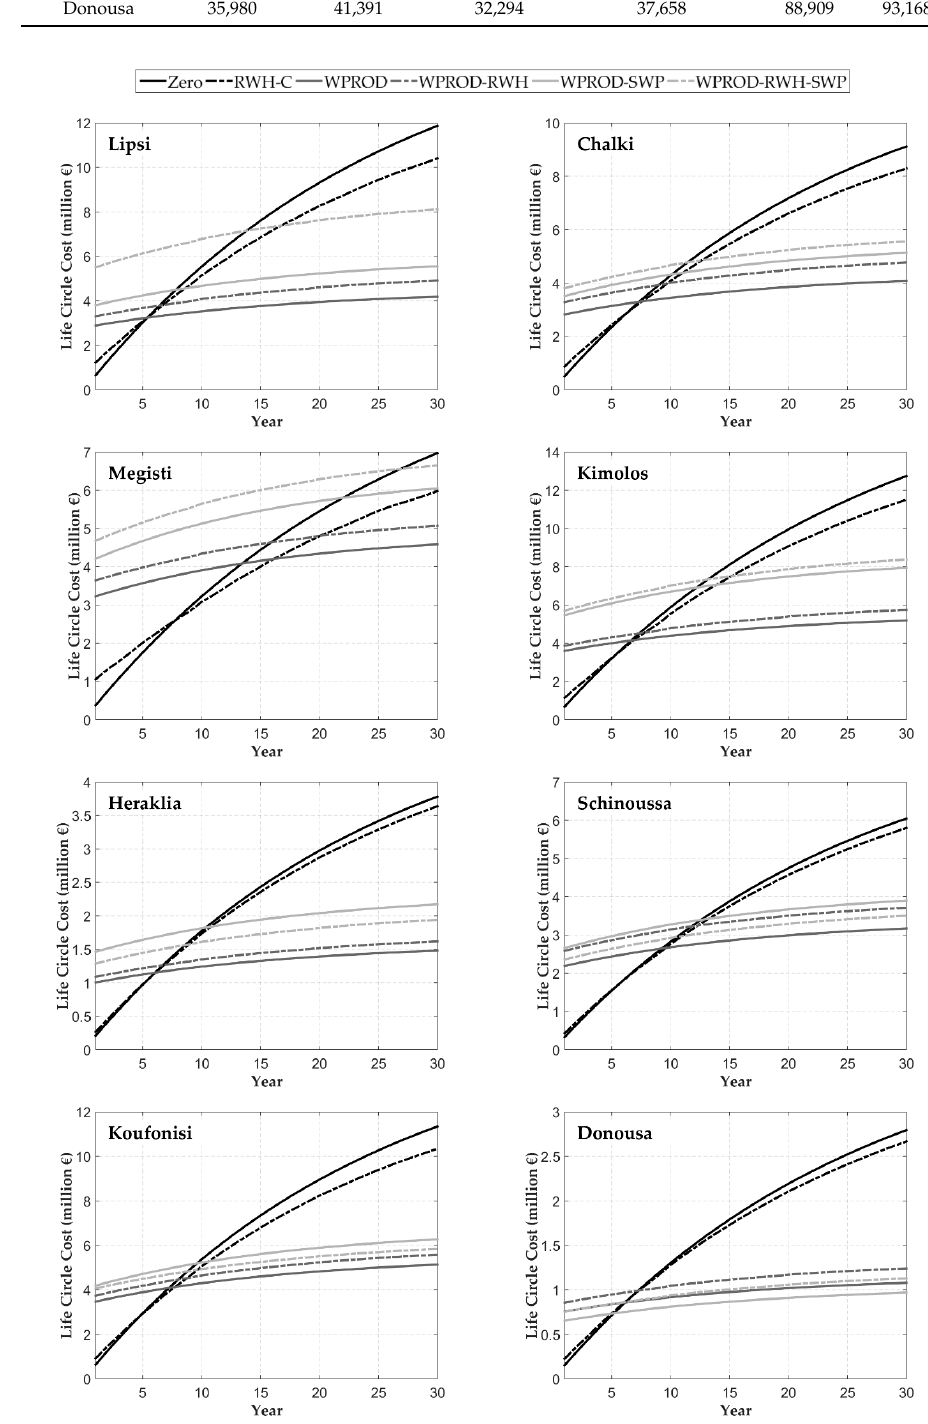
Figure 5. LCC analysis for all examined scenarios.